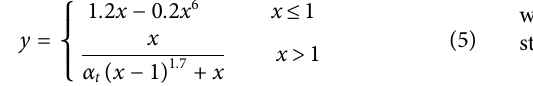
Frontiers in Materials |